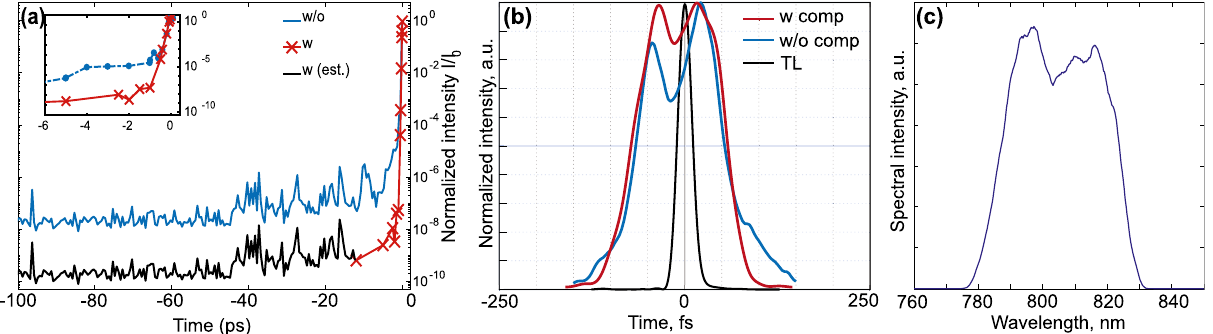
Figure 1. ( a ) Temporal contrast measured by a third-order cross-correlator, with and without DPM. The inset zooms in the last few ps before the main pulse, after the triggering of the DPM. The black curve is an estimation of the contrast when the signal is below the sensitivity of the cross-correlator. ( b ) Temporal shape retrieved by FROG on high-power shots, for the fully compressed pulse (transform-limited, TL), and for a chirped pulse 4 ) with and without compensation of the asymmetry. ( c ) The spectrum of the laser ( b ≈ +